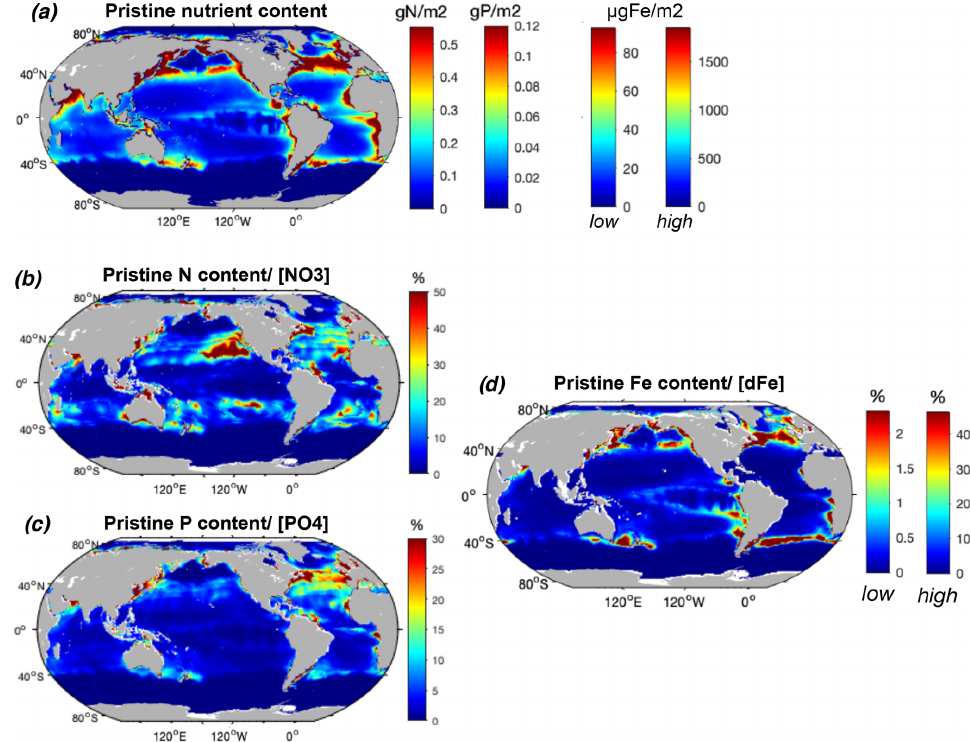
Figure 4. Modeled commercial pristine fish biomass mean nutrient content and relative to surface nutrient concentrations. (a) P content (mmolPm − 2 ), N content (mmolNm − 2 ), and Fe content (low and high estimates, µmolFem − 2 ) of the global pristine CTF 100kg biomass, 10g and (b) N content relative to surface NO − concentrations (%), (c) P content relative to surface PO 3 − concentrations (%), and (d) Fe content 3 4 (low and high estimates) relative to modeled surface dissolved Fe (%) from the TOPAZ model (Dunne et al., 2013). All surface concentrations are integrated over the 2002–2019 annual mean euphotic depth (Aqua MODIS, 2018). The N, P, and Fe content of fish is represented on a single map given that we used a globally constant nutrient ratio for each element, so that all spatial variation is caused by fish biomass.